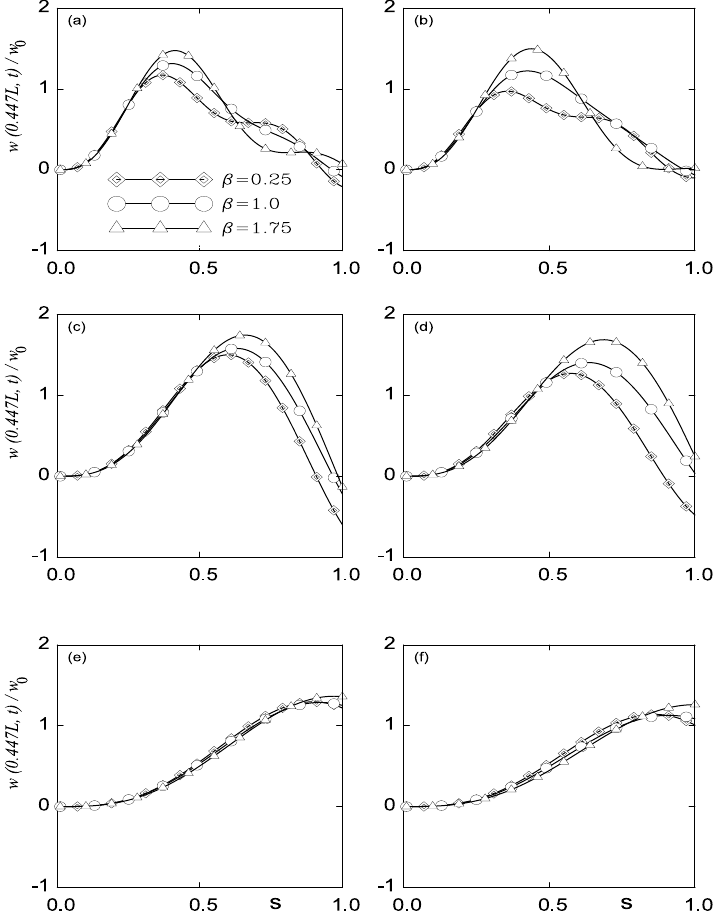
Fig. 7. Dynamic response ( w (0 . 447 L, t ) /w 0 ) for a hinged- fi xed beam: (a) α = 0.25, ζ n = 0.1, (b) α = 0.25, ζ n = 0.2, (c) α = 0.5, ζ n = 0.1, (d) α = 0.5, ζ n = 0.2, (e) α = 1, ζ n = 0.1, (f) α = 1, ζ n =